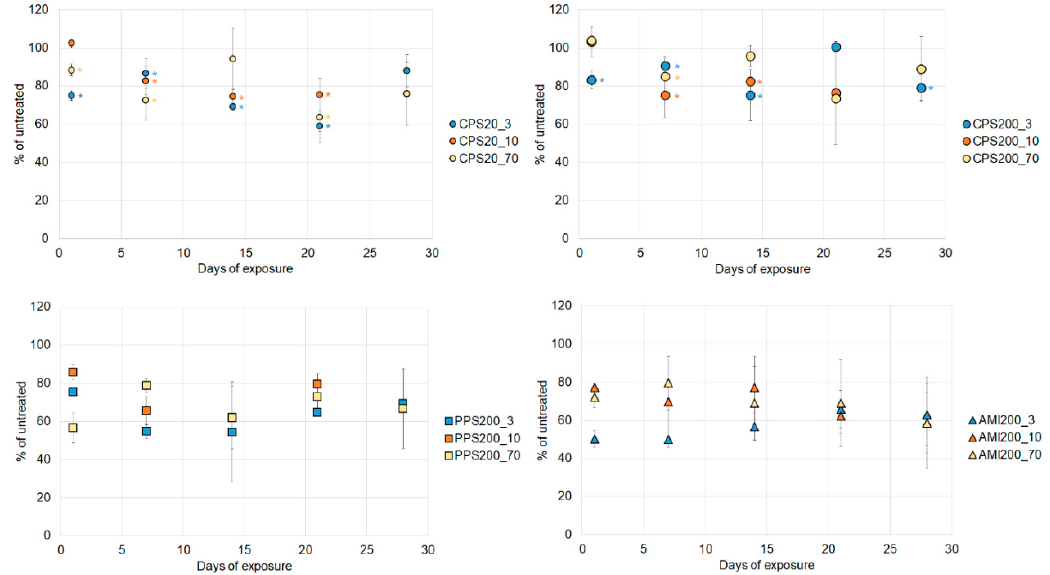
Figure 7. Uptake of 3 kDa, 10 kDa and 70 kDa dextrans by A549 cells. Decrease induced by PPS200 and AMI200 particles were all significant. For exposures to CPS20 and CPS200 particles, significant changes are indicated by asterisks in the respective color.